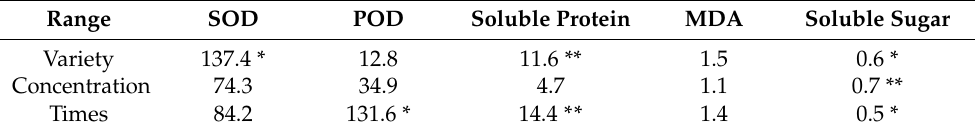
Table 3. Range analysis of the L9 (3 4 ) orthogonal experimental design assessing physiological factors. Range SOD POD Soluble Protein MDA Soluble Sugar Variety 137.4 * 12.8 11.6 ** 0.6 * Concentration 74.3 34.9 4.7 1.1 0.7 ** Times 84.2 131.6 * 14.4 ** 1.4 0.5 *